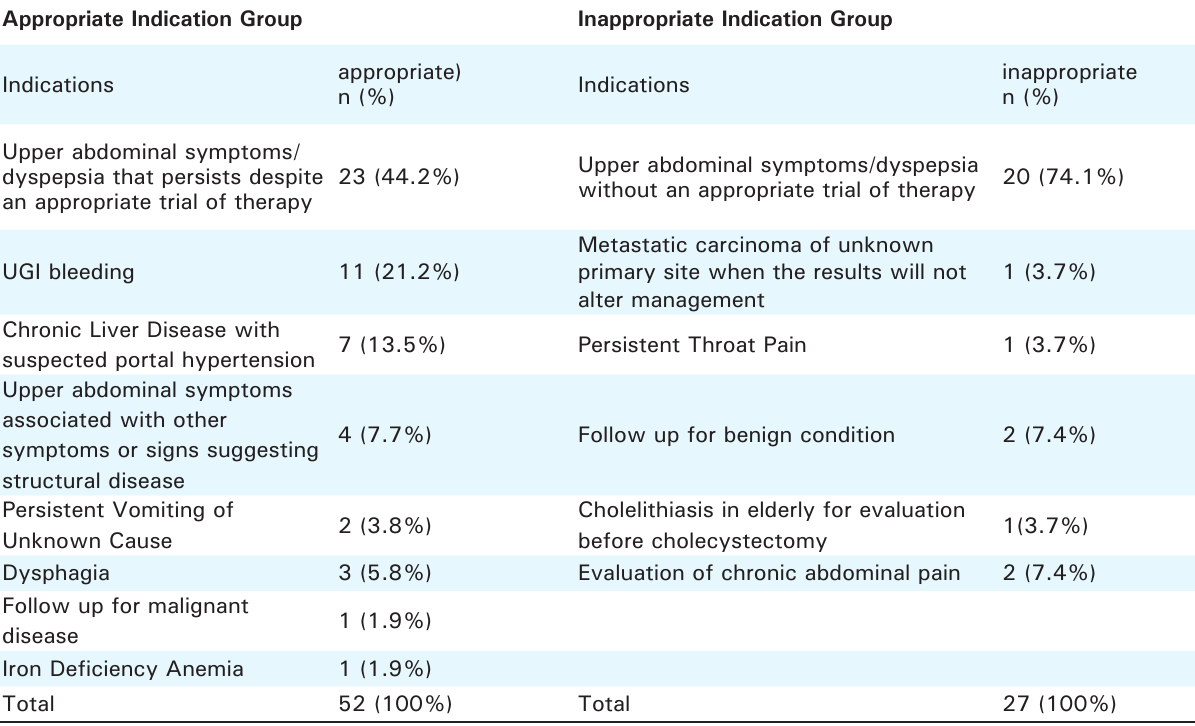
Table 2. UGIE Indications according to appropriateness as per ASGE